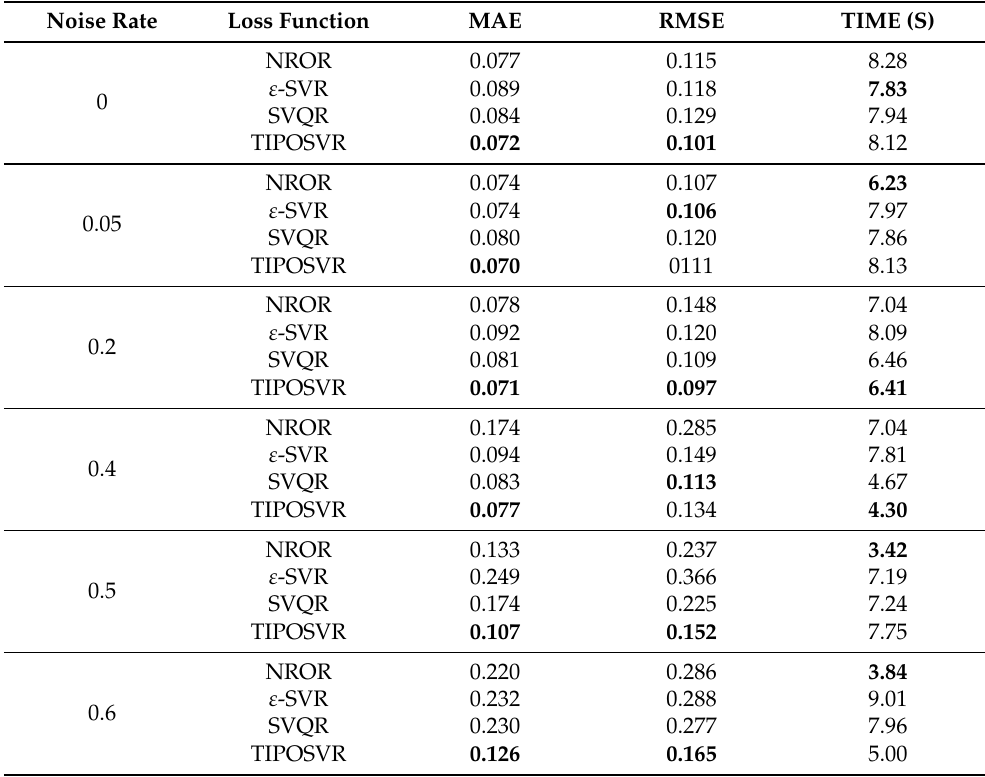
Table 6. Operation results of algorithms under the influence of noise typeIV for synthetic dataset. Noise